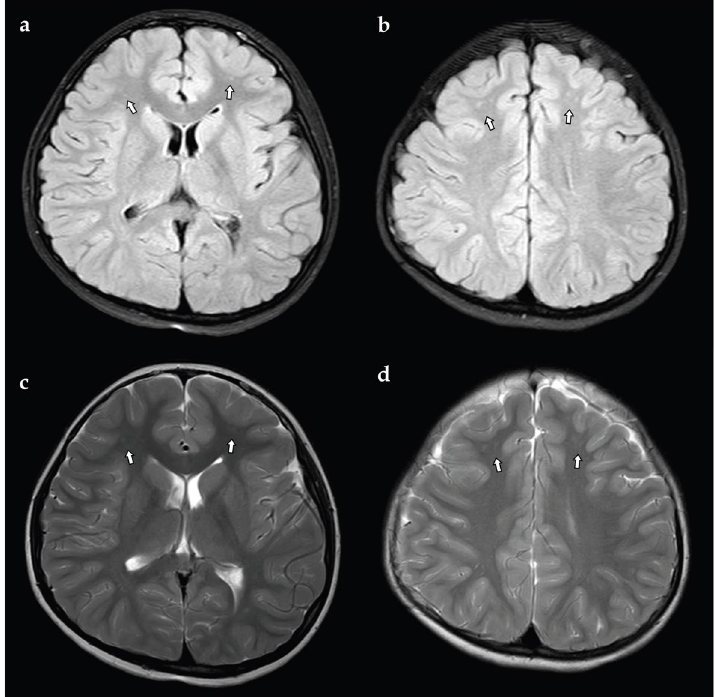
Fig. 1 Cranial magnetic resonance imaging (MRI) showed scattered foci of long T1 signal in the bilateral inferior frontal cortex (arrows in a , b ) and high signal on T2-weighted FLAIR (arrows in c , d